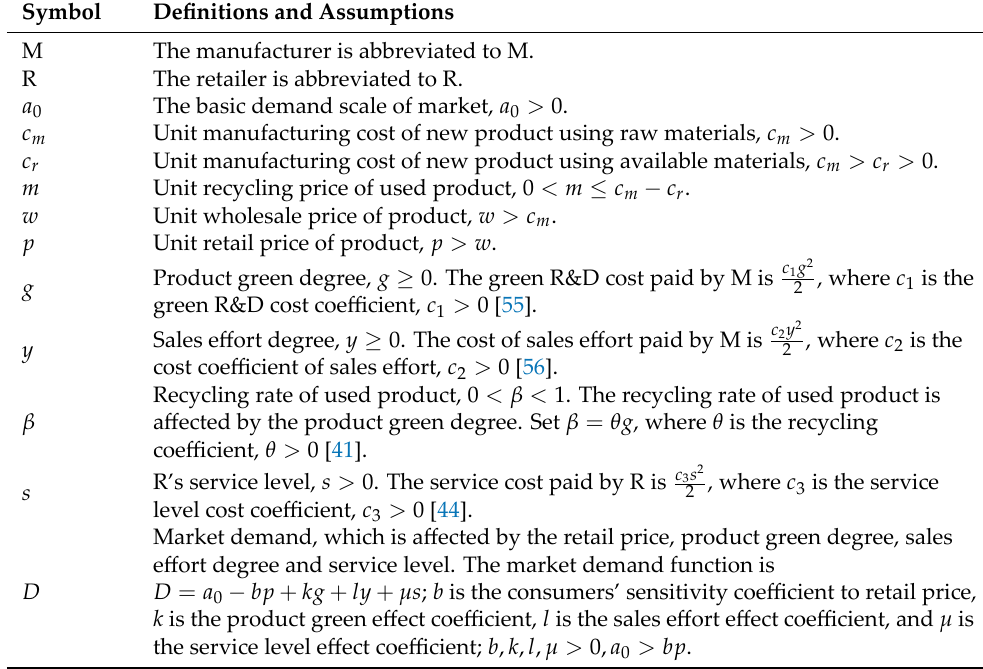
Table 1. Parameter symbol definitions and